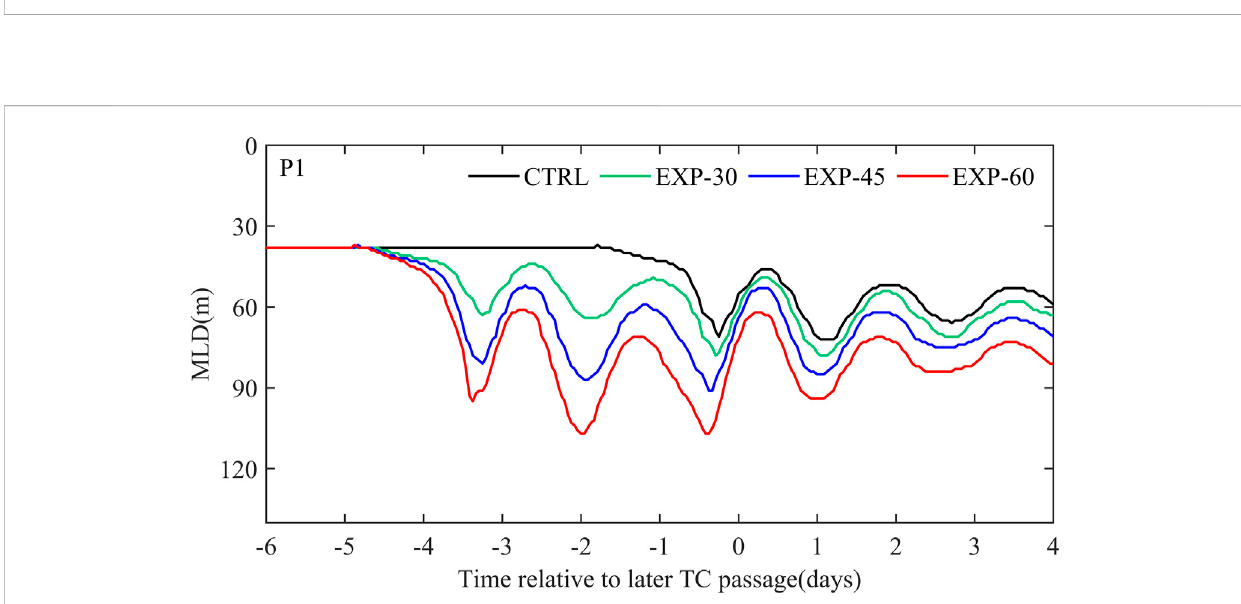
FIGURE 12 ThetemporalevolutionoftheMLD(m)duringTCpassage,day0referstothedayoftheLTCarrivalonthelocalposition.Thedifferentlycoloredsolid lines indicate different idealized model